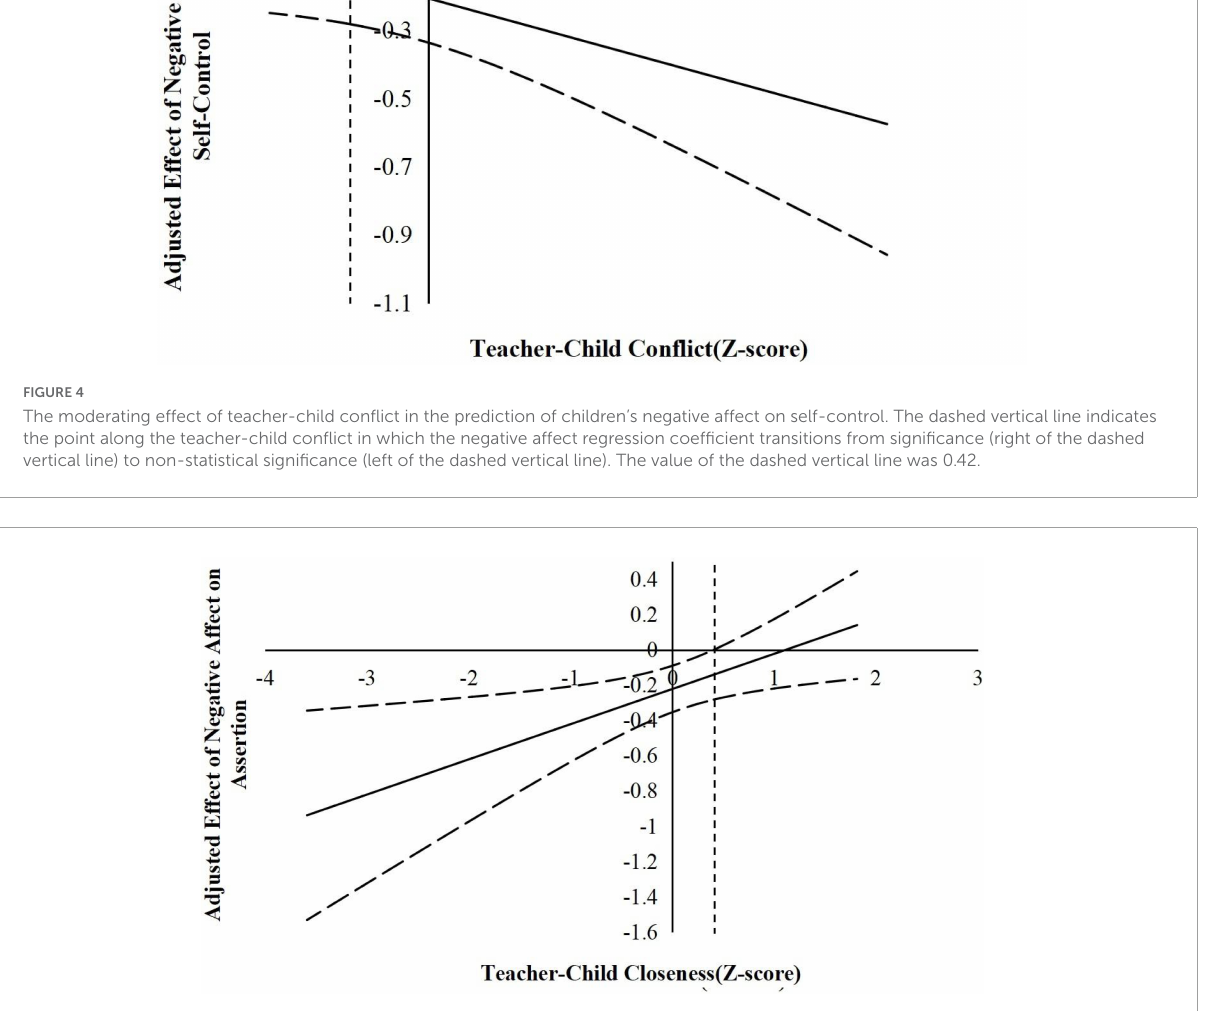
FIGURE5 The moderating effect of teacher-child closeness in the prediction of children’s negative affect on the assertion. The dashed vertical line indicates the point along the teacher-child closeness in which the negative affect regression coefficient transitions from significance (left of the dashed vertical line) to non-statistical significance (right of the dashed vertical line). The value of the dashed vertical line was